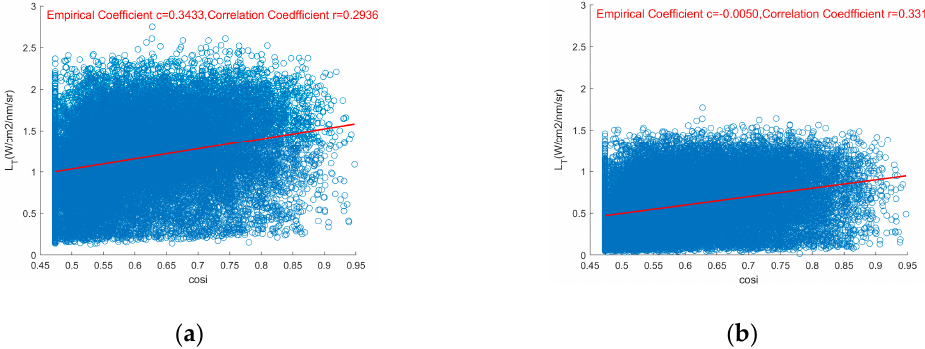
Figure 8. The coe ffi cient fitting of ( a ) band112 and ( b ) band 156. Significance level is 0.10. Figure 8. The coefficient fitting of ( a ) band112 and ( b ) band 156. Significance level is 0.10.